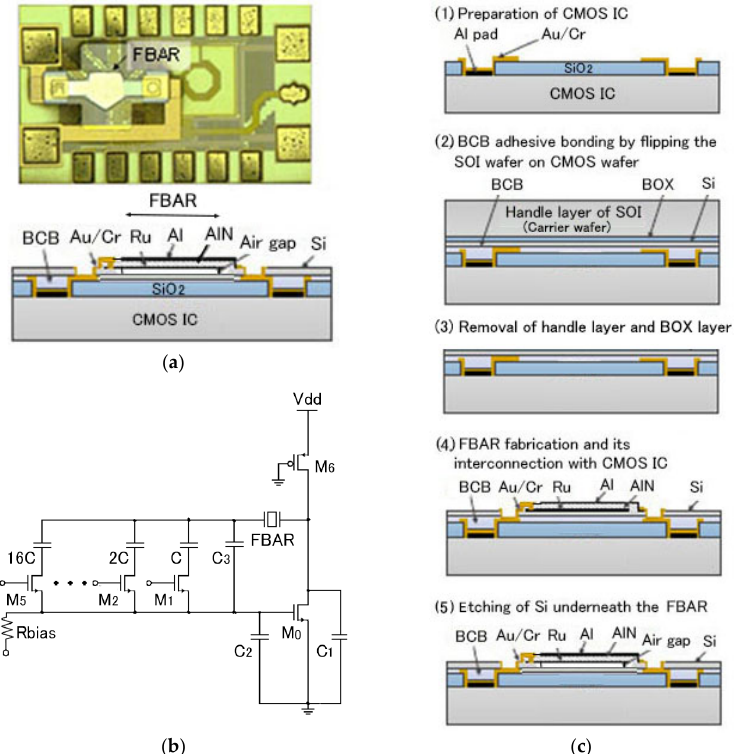
Figure 4. FBAR on LSI; ( a ) photograph and structure; ( b ) CMOS oscillation circuit; and ( c ) fabrication process.